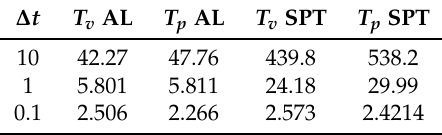
Table 5. Temporal convergence of the error on the velocity and the pressure for the augmented Lagrangian and the rotational pressure-correction methods for large time steps for the Couette flow. ∆ t